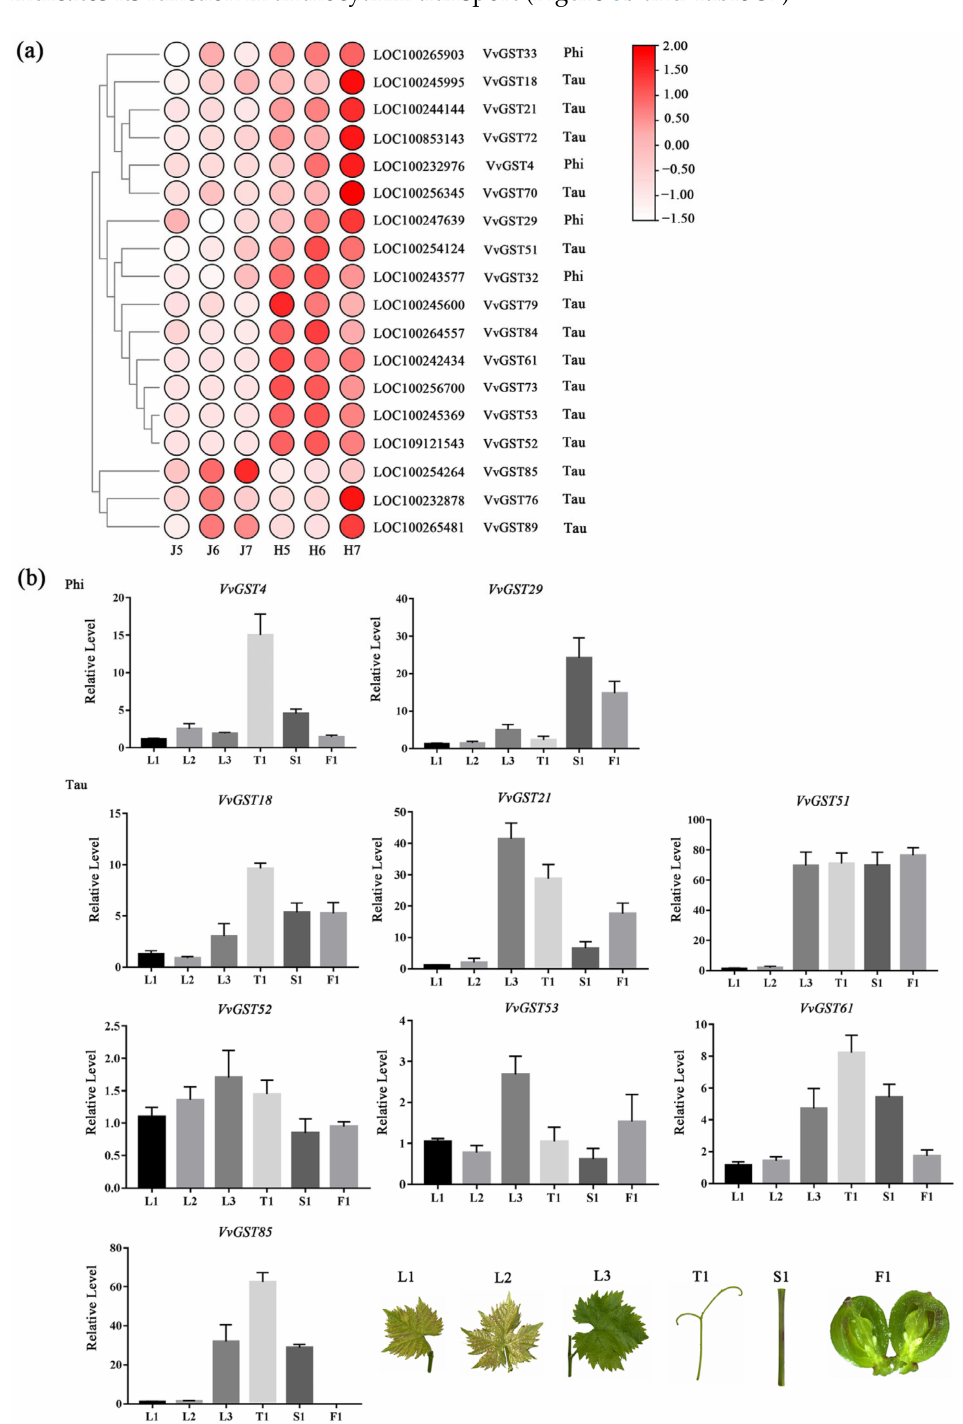
Figure 8. Heat map of the expression patterns of GST genes and relative expression of GST genes in six tissues. ( a ) Heat map of the expression patterns of the GST genes. The expression levels of genes are shown using different colors from white ( − 1.5) to red (2), with the values representing the log2 FPKM values. A redder color indicates a higher gene expression level. ( b ) Relative expression of GST genes in six tissues. The left y-axis represents the relative gene expression levels analyzed by